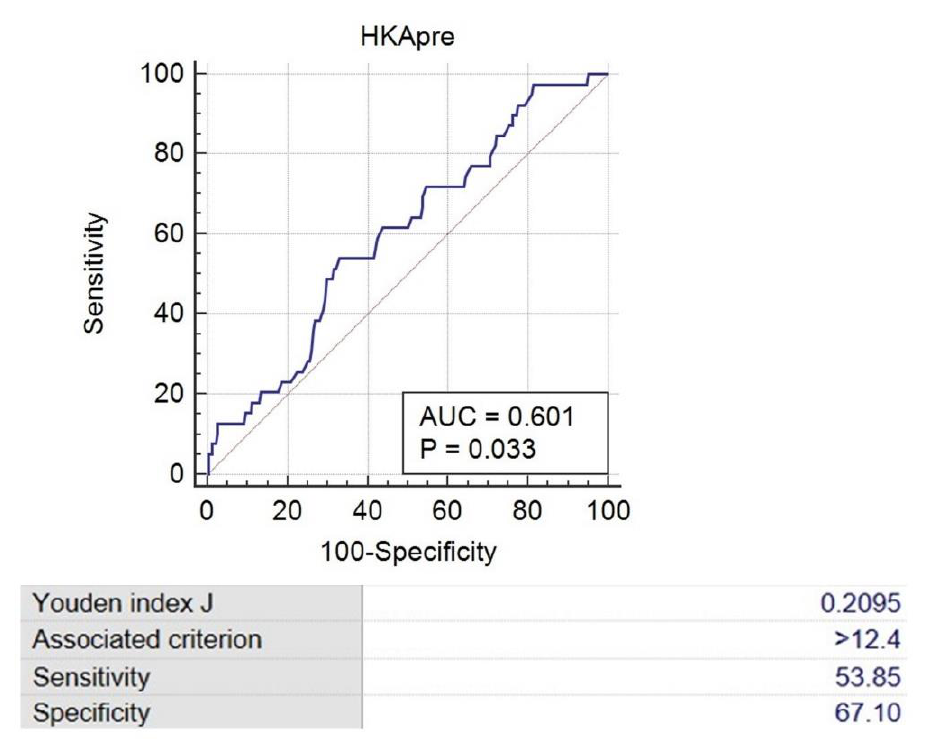
Figure 5. Receiver operating characteristic curve to evaluate cutoff value of preoperative HKA that discriminates rectangular and trapezoidal gap.